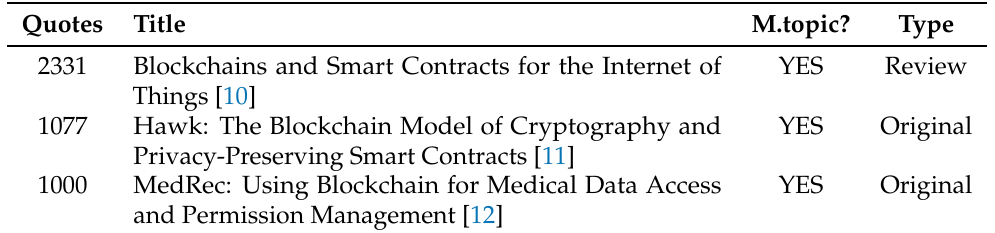
Table 3. Top 3 citations 2016.